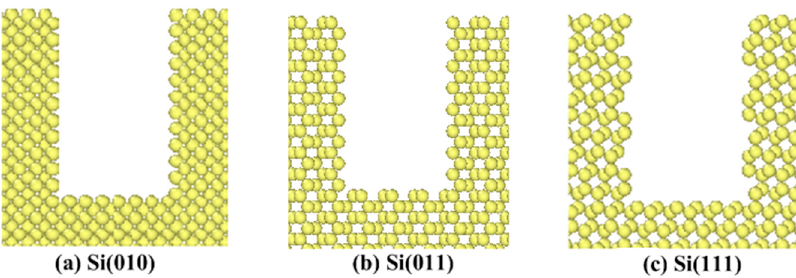
Figure 3. Influences of the anisotropy on pore walls.